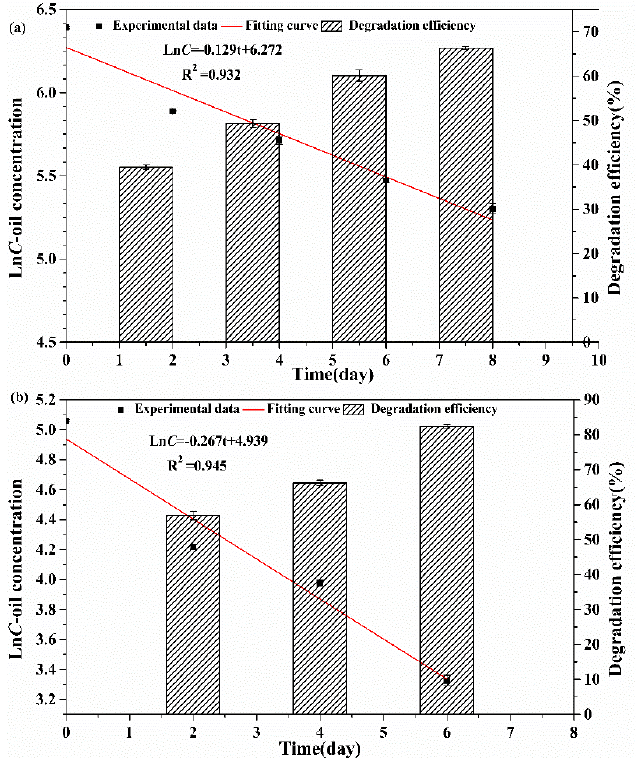
Figure 3. Degradation efficiencies and degradation kinetics of the ( a ) bacterial consortia and ( b ) laccase-bacterial consortia for saturated hydrocarbons. ( b ) laccase-bacterial consortia for saturated